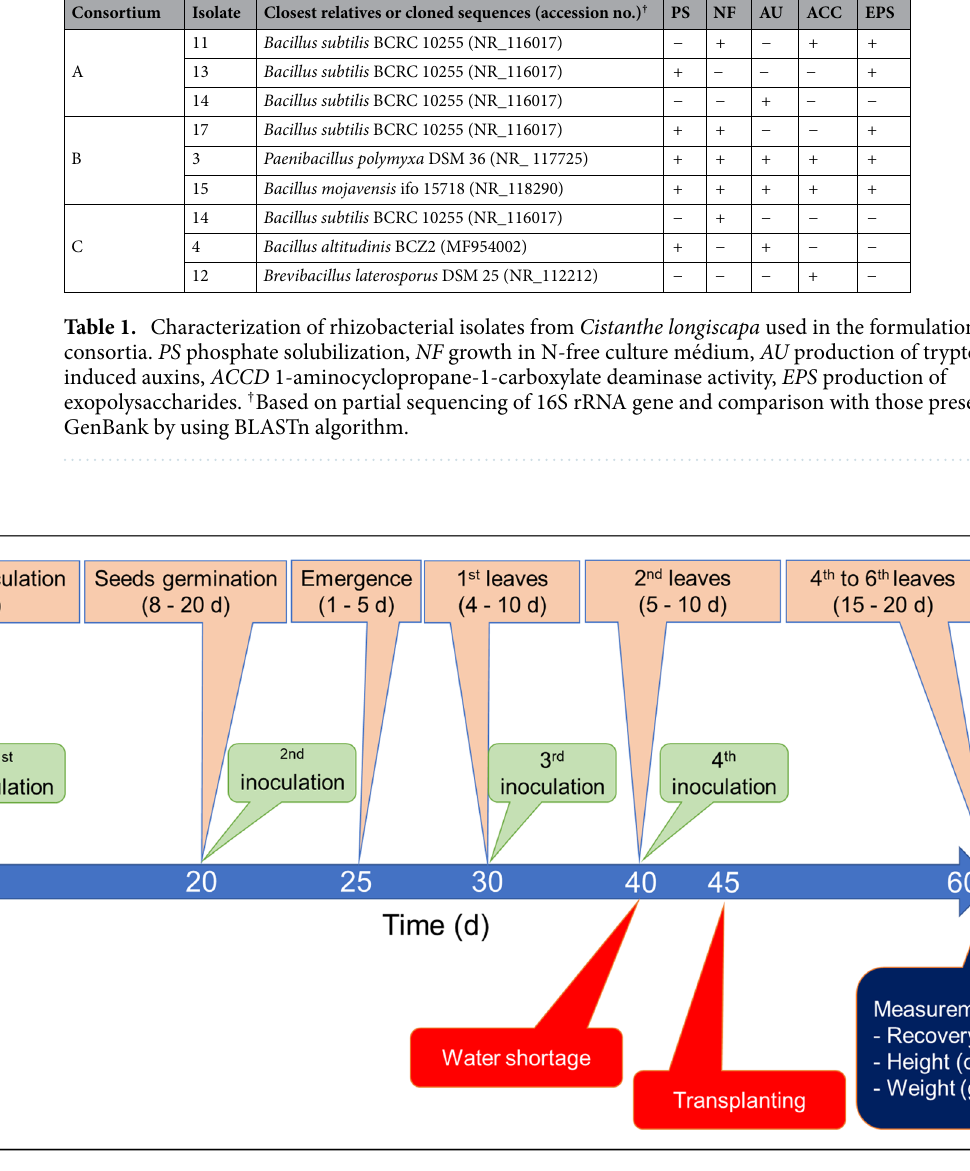
Figure 2. Experimental design of the plant inoculation assay with the formulated rhizobacterial